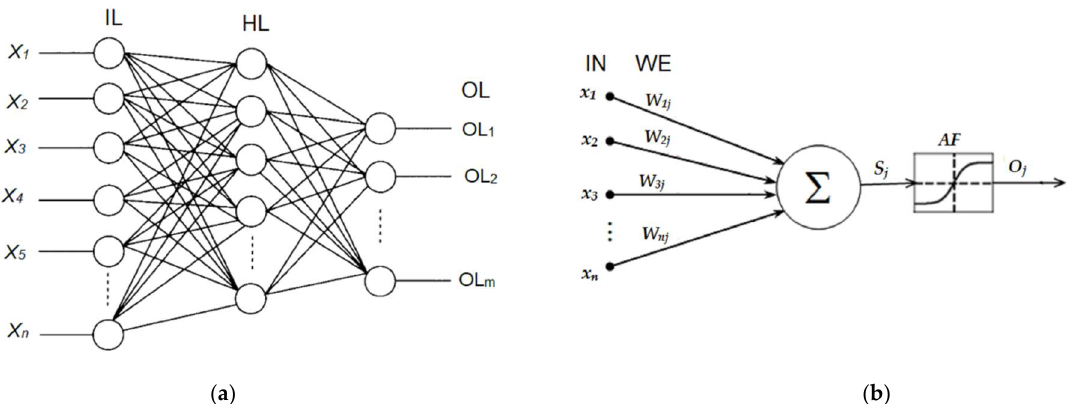
Figure 1. Schemes for the structure description of the artificial neural networks (ANNs): ( a ) Description of neural network architecture: IL —input layer, HL—hidden layer, and OL—output layer; ( b ) Description of neural network active node: IN—inputs, WE—weights, AF—activation function, S j —sum of the weighted input, and O j —output activation function.